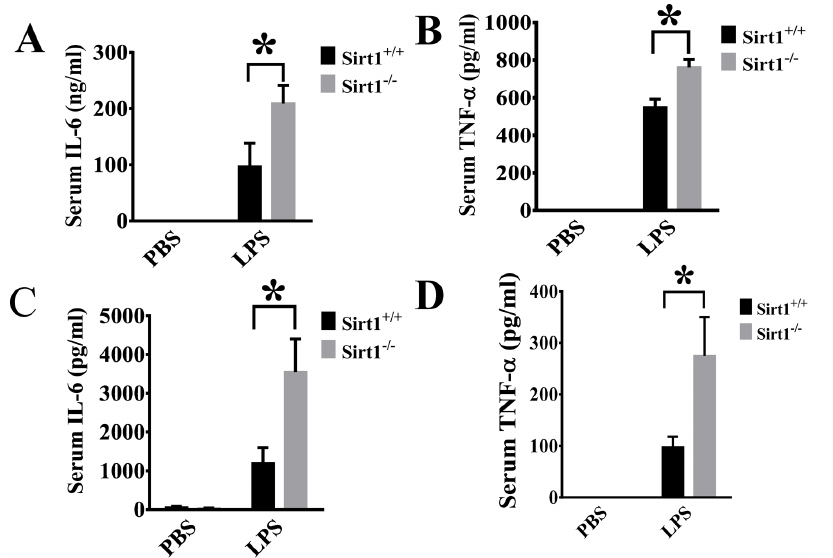
Figure 3. Sirt1 deletion causes significant increase of pro-inflammatory cytokine production after LPS challenge. Serum IL-6 and TNF- alpha levels were measured by ELISA 6 h (A, B) or 24 h (C, D) after LPS challenge (n $ 4 mice/group). *P , 0.05 versus Sirt1 + / + /LPS group.